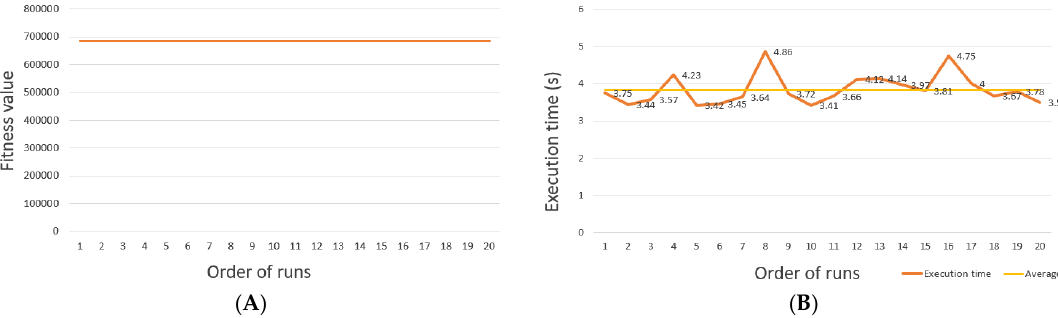
Figure 13. ( A ) the objective values of genetic algorithm corresponding to different initial points. ( B ) the execution times of genetic algorithm corresponding to different initial points.